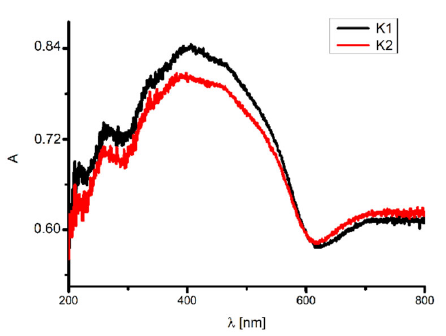
Figure 9. Solid state absorption spectra of black K1 and red K2 ., A—absorbance. Emission Studies